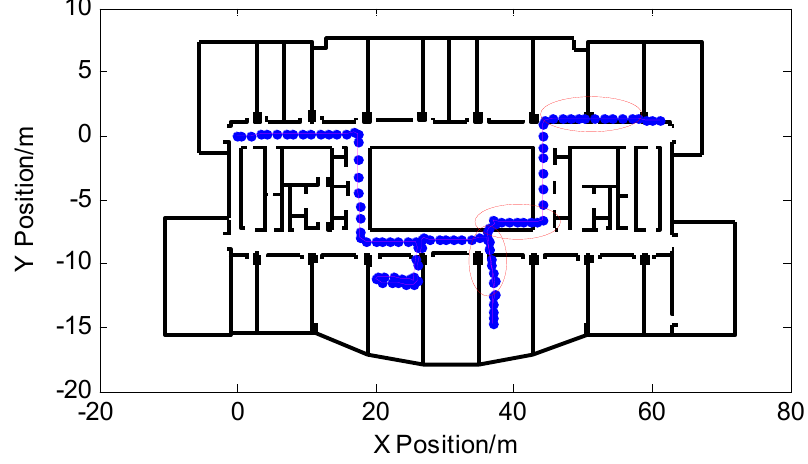
Figure 16. Pedestrian trajectory before correction.